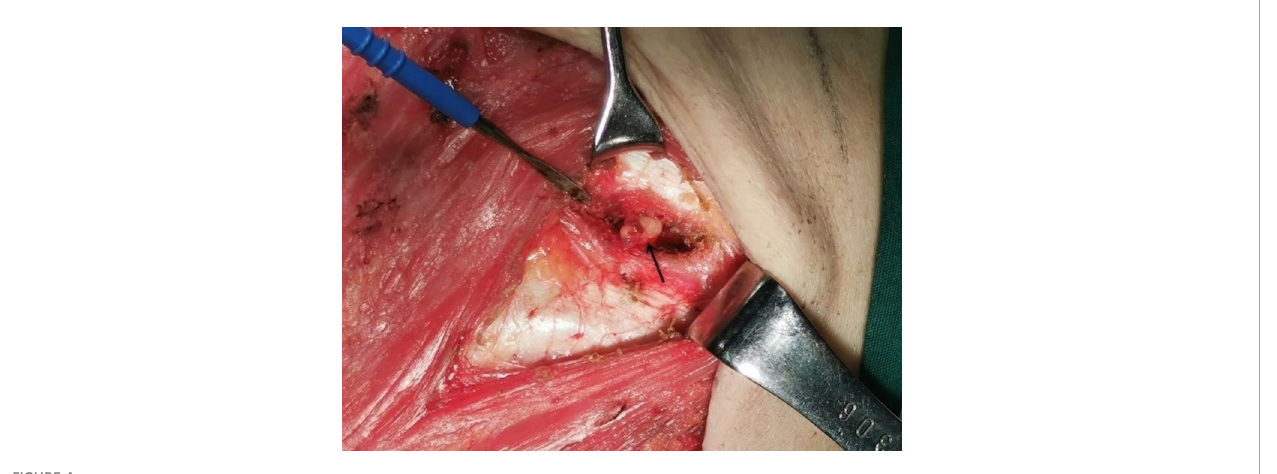
TABLE 2 Comparison of the detection rates of IM-SLN and A-SLN with different injection methods. Characteristics Two-site (n=60)